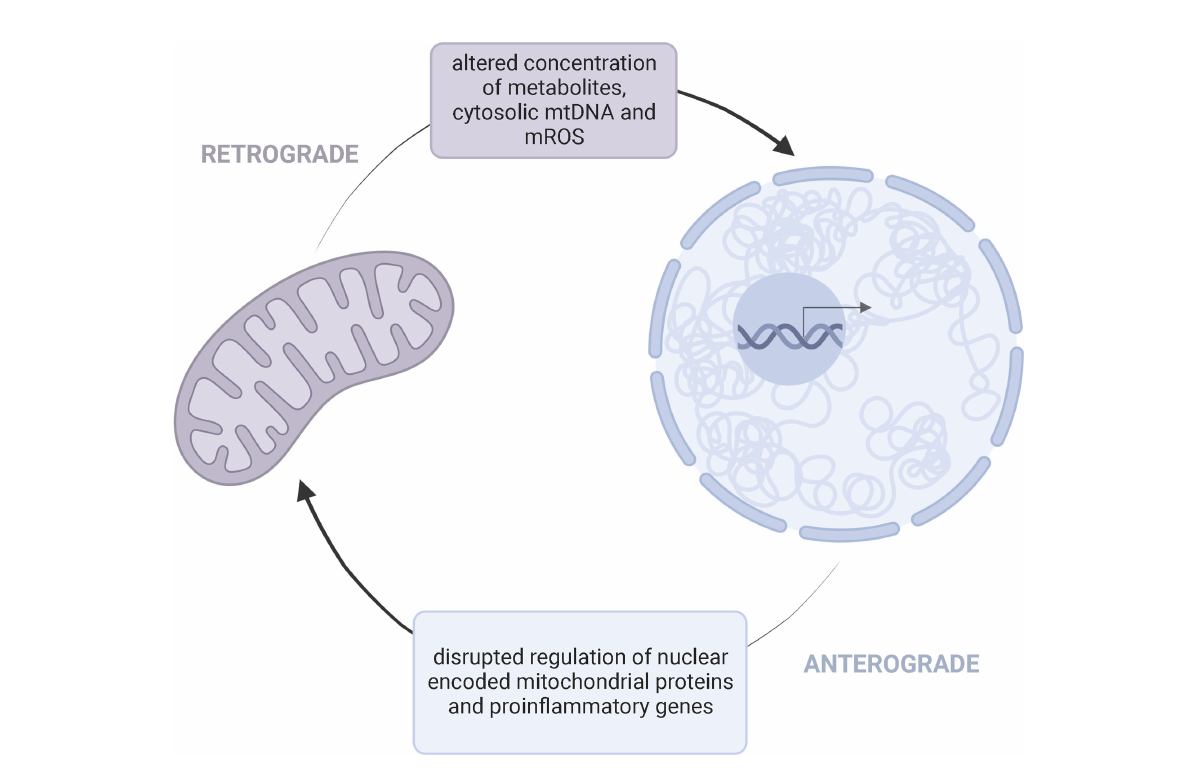
FIGURE 3 Bidirectional Mito-Nuclear CrosstalkMitochondria and the nucleus communicate through retrograde (purple) and anterograde (blue) signaling pathways. This bidirectional crosstalk allows a cell to maintain homeostasis and adapt to various pressures. Retrograde (mitochondria-to- nucleus) communication in fl uences the regulation of nuclear encoded mitochondrial proteins and expression of proin fl ammatory genes through altered concentration of metabolites, cytosolic mtDNA, and mROS. Anterograde signaling, as a response, can further in fl uence the availability of mitochondrial derived metabolities needed for cell survival and disrupt mitochondrial oxidative ef fi